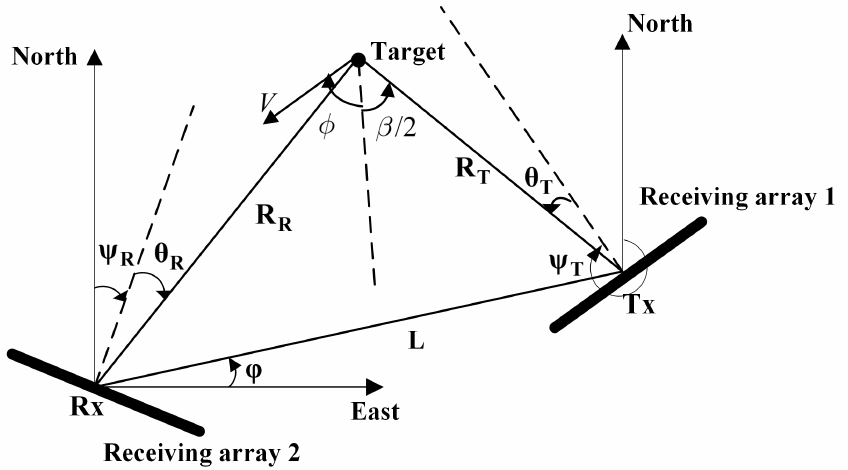
Figure 1. The radar configuration geometry of a T/R-R high-frequency surface wave radar (HFSWR) system. The transmitter and receiving array 1 are deployed at the transmitting station (Tx), while receiving array 2 is deployed at the receiving station (Rx). The transmitter serves the two receiving arrays simultaneously. The distance L between the transmitter and receiver is called the bistatic range or simply the baseline. ϕ denotes the angle between the baseline and East direction. Denote ψ T and ψ R , respectively, as the radar look directions of receiving array 1 and receiving array 2 with respect to true North. β is the bistatic